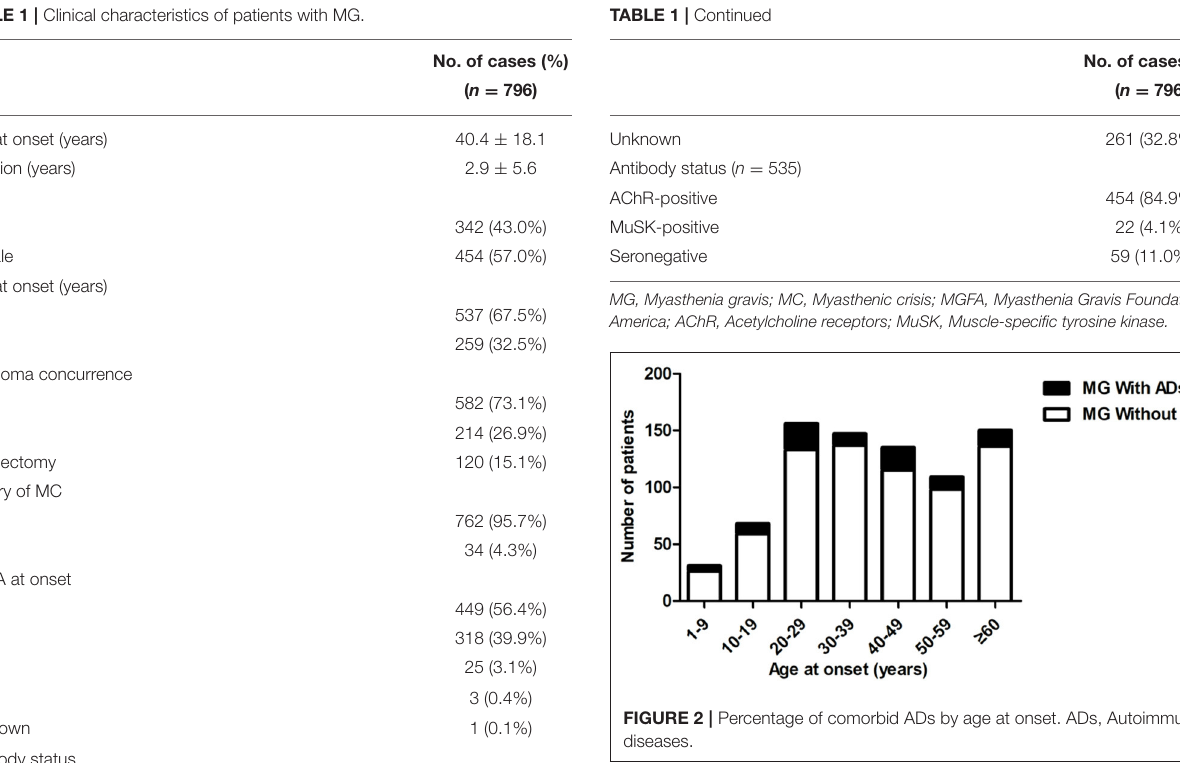
male patients: 9.6 vs. 3.0%, female patients: 13.0 vs. 7.1%) (15). The percentages of comorbid ADs varied among different onset age groups (from 6.8 to 16.1%, Figure 2 ). The percentages of comorbid ADs in patients with early